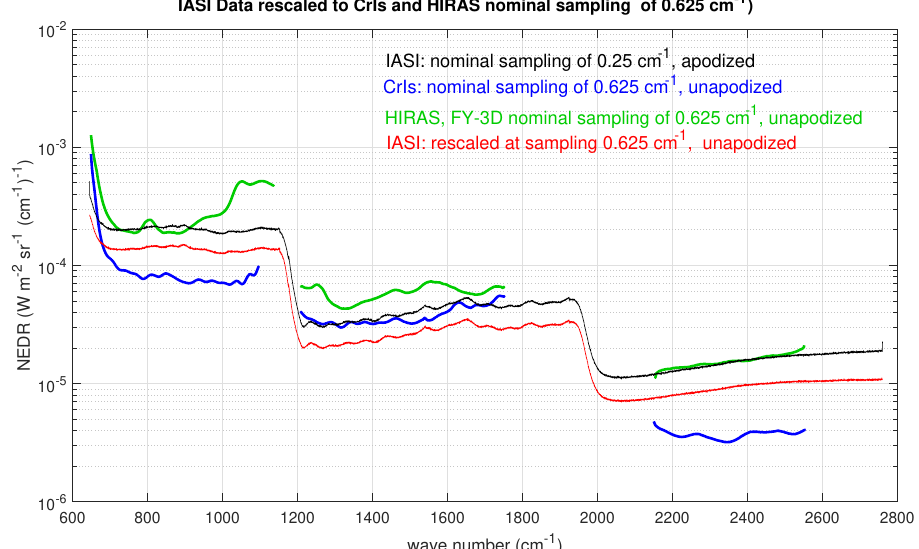
Figure 14. Comparison of IASI, CrIS, and HIRAS radiometric noise. The CrIS data shown in the figure are those provided to us by Han et al. [17], which apply to the CrIS standard sampling of 0.625 cm − 1 . In this way, they can be directly compared to those of HIRAS. For IASI, we show both the radiometric noise at the original sampling and those properly rescaled at CrIS standard